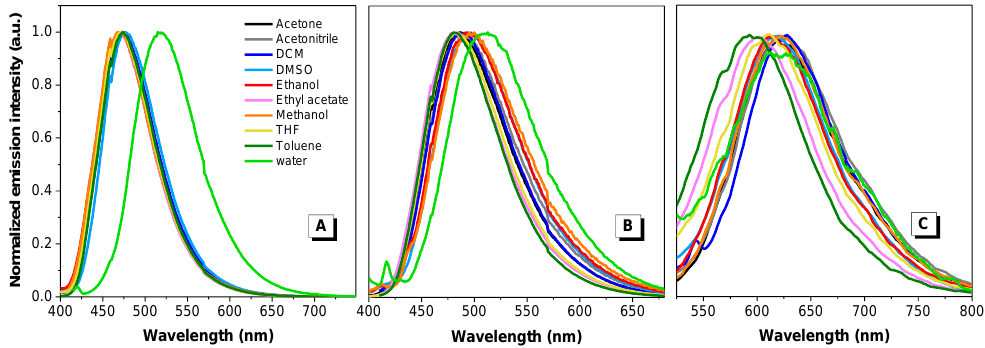
Figure 4. Normalized emission spectra of dyes 1 ( A ), 2 ( B ) and 3 ( C ) in different solvents. Concentration = 10 µM.